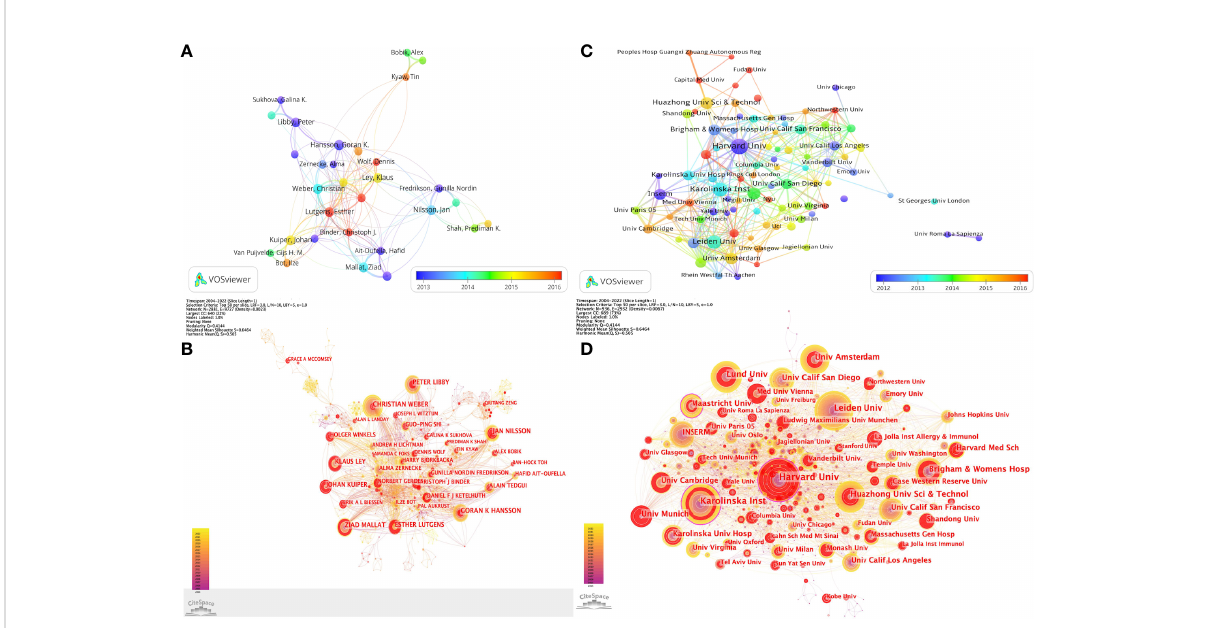
FIGURE 4 Collaboration networks among authors and among institutions in T cell and AS. (A) A visual map for VOSviewer network among authors. (B) A visual map for CiteSpace network among authors. (C) A visual map for VOSviewer network among institutions. (D) A visual map for CiteSpace network among institutions.